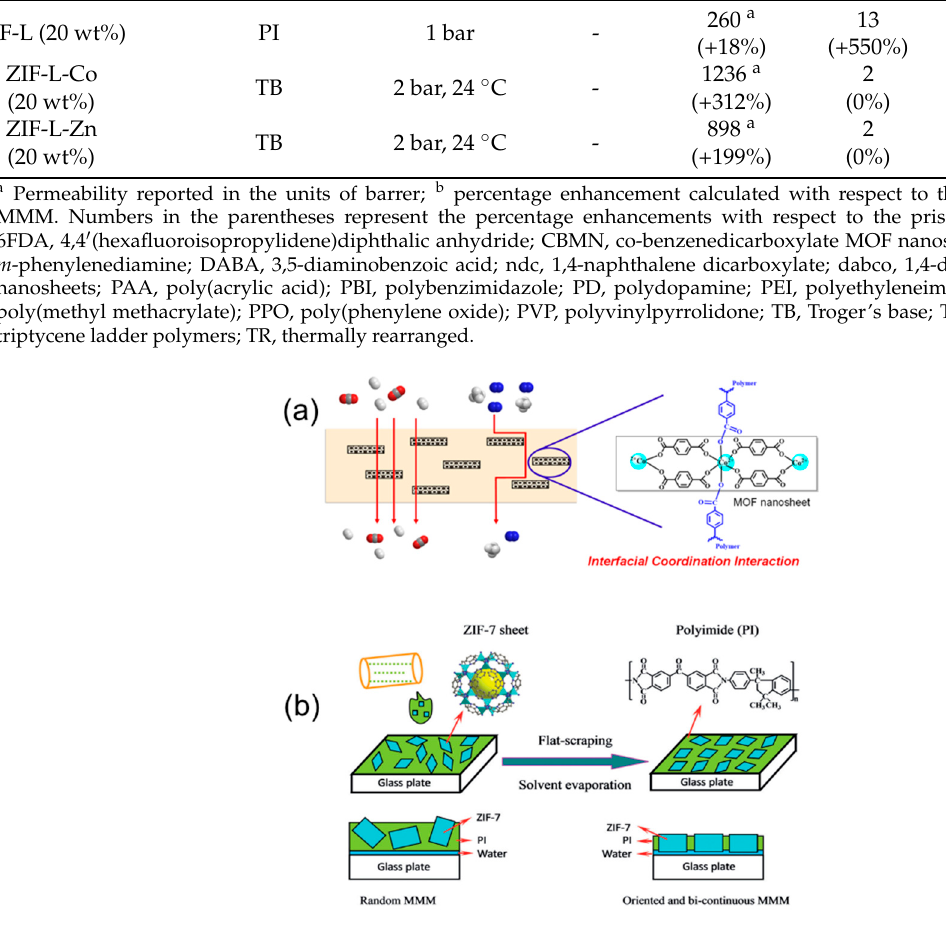
Figure 6. Illustration of ( a ) the 6FDA-Durene-DABA/CBMN MMM. Reprinted with permission from Ref. [113], Copyright 2020 American Chemical Society, and ( b ) a schematic showing the preparation of the oriented and penetrating ZIF-7@PI MMM. Reprinted with permission from ref. [85]. Copyright 2019 Wiley-VCH. Table 3. Summary of representative performances for MOF-based membranes in H 2 -based separation. Membrane